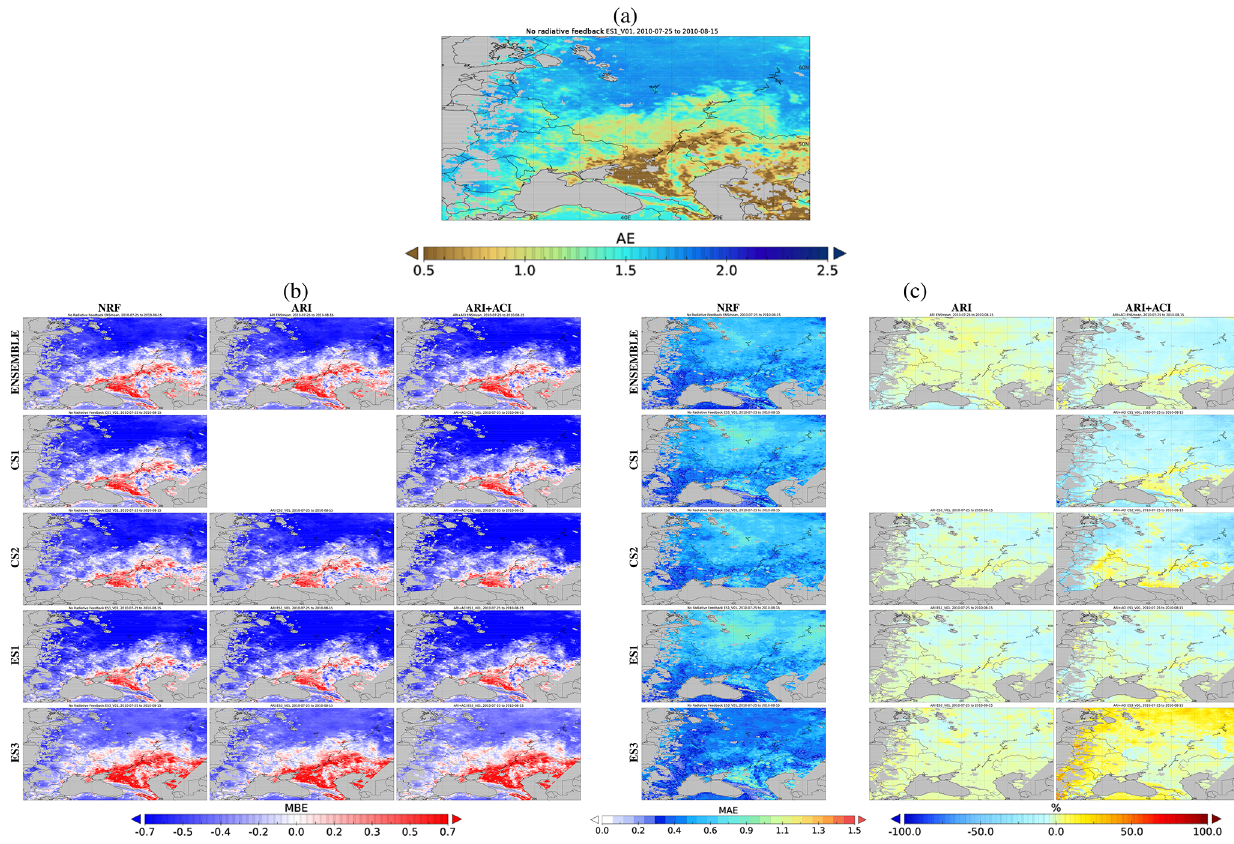
Figure 4. Model-MODIS comparison of AE between 412 and 470nm for the Russian wildfires case: (a) satellite values; (b) MBE for NRF (first column), ARI (second) and ARI + ACI (third); and (c) MAE for the NRF simulations (first column) and their improvements due to ARI (second) and ARI + ACI